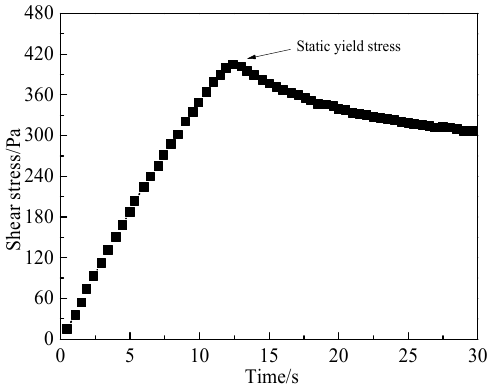
Figure 1. A typical development curve of shear stress [30].